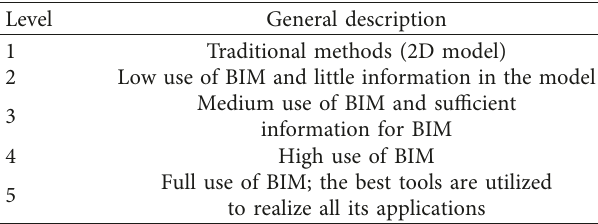
Table 2: BIM levels—a general description for each level.